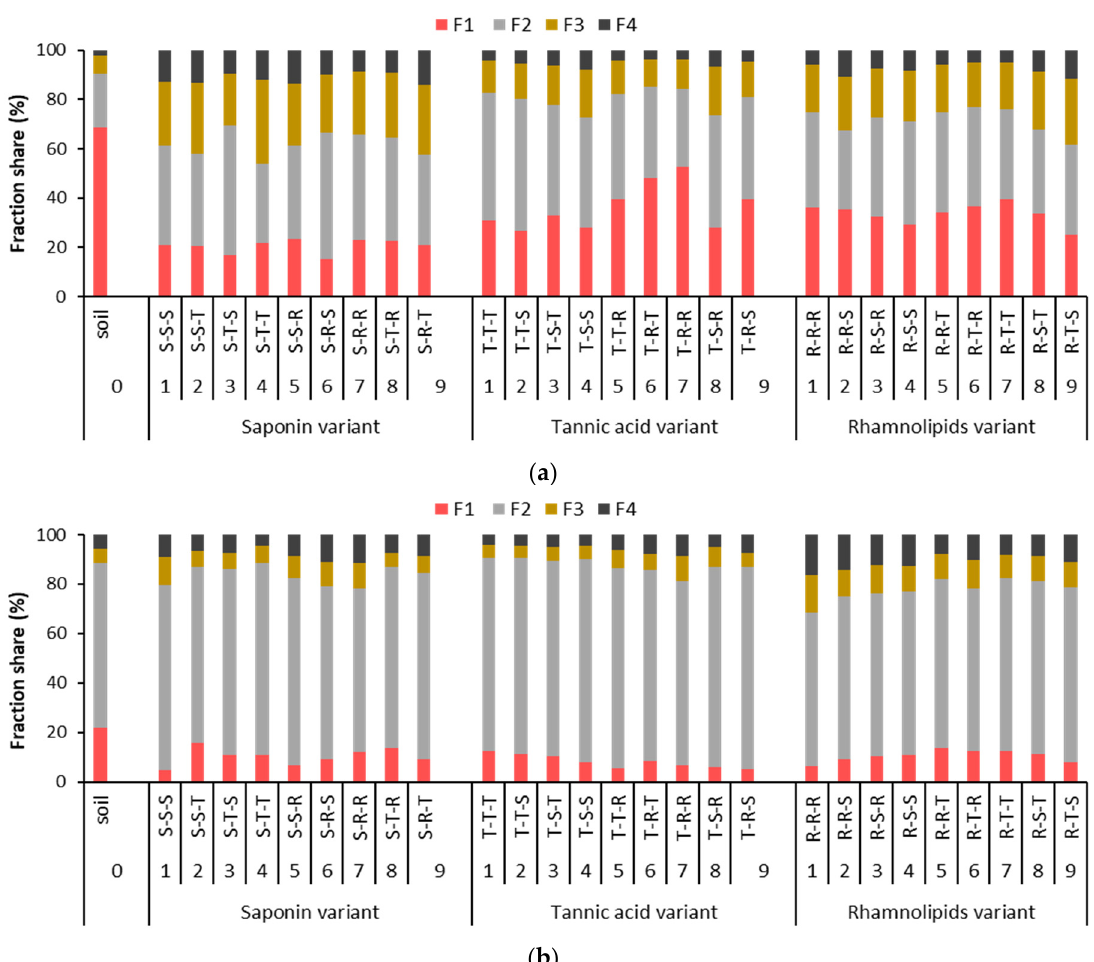
Figure 5. Changes in the share of individual metal fractions in soil after triple washing with the use of saponin, tannic acid or rhamnolipids variants: ( a ) Cu, ( b ) Pb (soil 0 refers to unwashed soil).